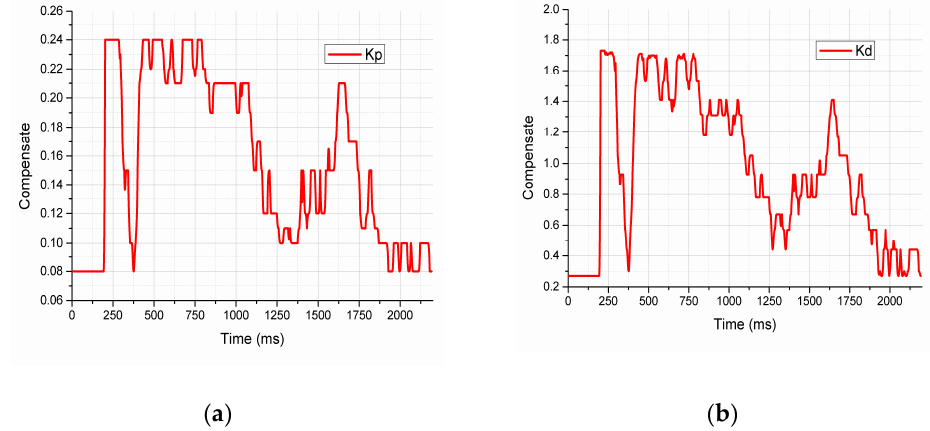
Figure 12. PID gain parameter tendency chart after modulation by DRL-Fuzzy-PID controller. ( a ) k p , ( b ) k d